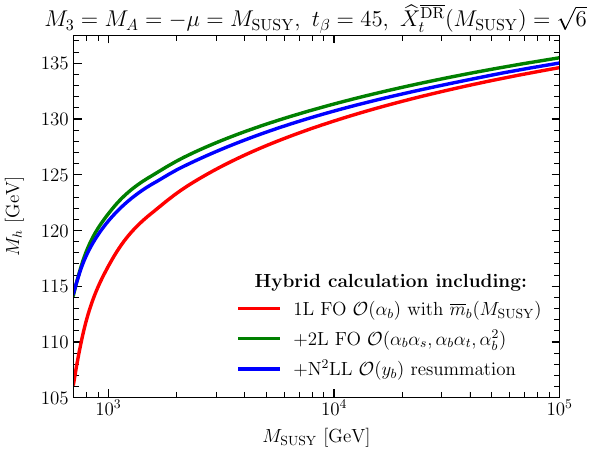
Fig. 2 M h as a function of M SUSY (left) and (cid:6) X DR t ( M SUSY ) (right). The redlinesshowthepredictionofourhybridcalculationincludingonlythe one-loop fixed-order O (α b ) correction. For the blue lines, we addition-